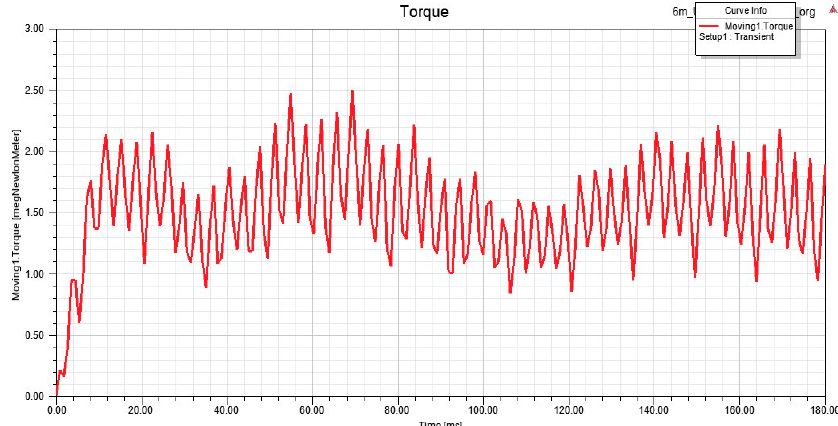
Figure 10. The curve of the electromagnetic torque of the CPSM in Maxwell 3D Design.